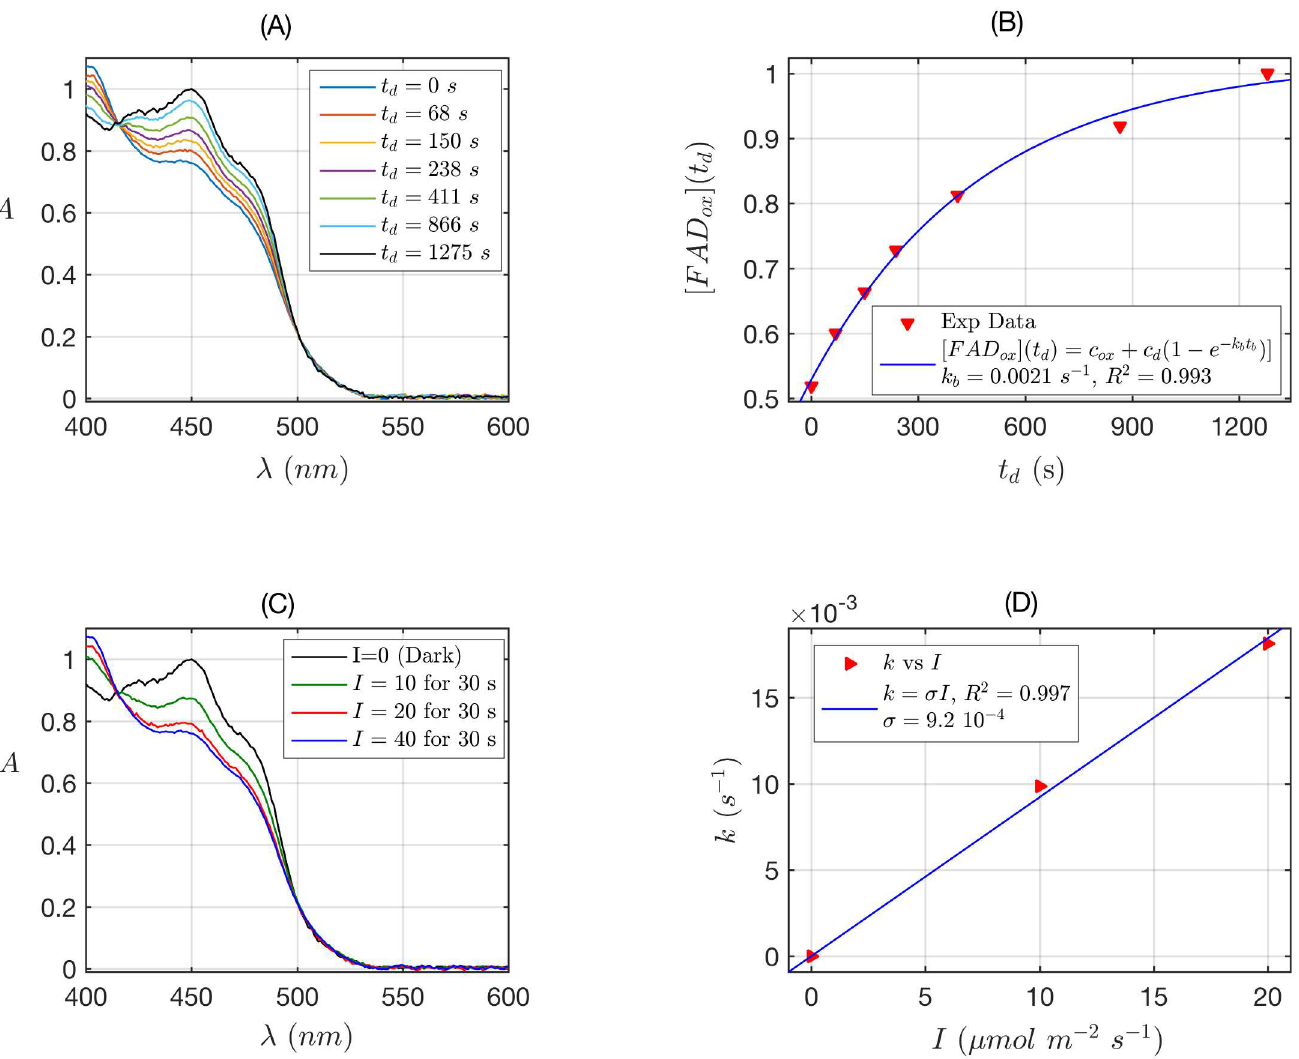
Fig 2. Rate constants and quantum yield for two-state reduction and reoxidation of DmCry. (A) Isolated purifiedDmCry protein was illuminated for 30 s at I = 40 μ mol m -2 s -1 blue light and placed in darkness(t d = 0 s). Normalized absorptionspectra are reportedat increasing dark reoxidationtimes t d . (B) Normalizedconcentration of FAD ox as a function of the dark reoxidationtime t d . The FAD ox concentration was obtainedfrom the absorbance at 450nmfrom panel A accordingto Eq. S7 (see S1 Text). The red trianglesrepresent the experimental data, and the blue curve is the fit of the experimental data with the two-states reoxidation model (Eq. S8). From the fit the reoxidation rate resulted k b = 0.0021s -1 , (half-life of τ 1/2 = 5.5 min). The goodness of the fit was excellent( R 2 (cid:25) 1). (C) Isolated purifiedDmCry protein was illuminatedfor 30 s at the indicatedblue light fluence rates I. Normalized absorptionspectra are presented. (D) Calculatedforward rate constant k versus photon fluencerate I (red triangles). For each I, the rate constant k was calculatedby numerically solvingthe two-states kinetic equations(see S1 Text, Eq. S1), with the concentration of FAD ox , obtainedfrom panelC and reoxidation k b obtained from panel B. We fit k as function of I by using the linear equationk = σ I. The fit is reportedas blue curve in Fig 2. From the fit the photo-conversion cross section was σ = 9.2 x 10 − 4 μ mol -1 m 2 . From σ the quantum yield ϕ was calculatedaccordingto σ = 2.3 ε ox (450) ϕ , by using the experimentally calculatedextinctioncoefficient ε ox (450) = 1130 mol -1 m 2 (11300M -1 cm -1 ). The quantumyield resulted ϕ = 0.35. Triton X-100. 80 μ l aliquots of the whole cell lysate were transferred to individual wells of a 96 well microtitre plates and measured at excitation/emission of 490/530nm.